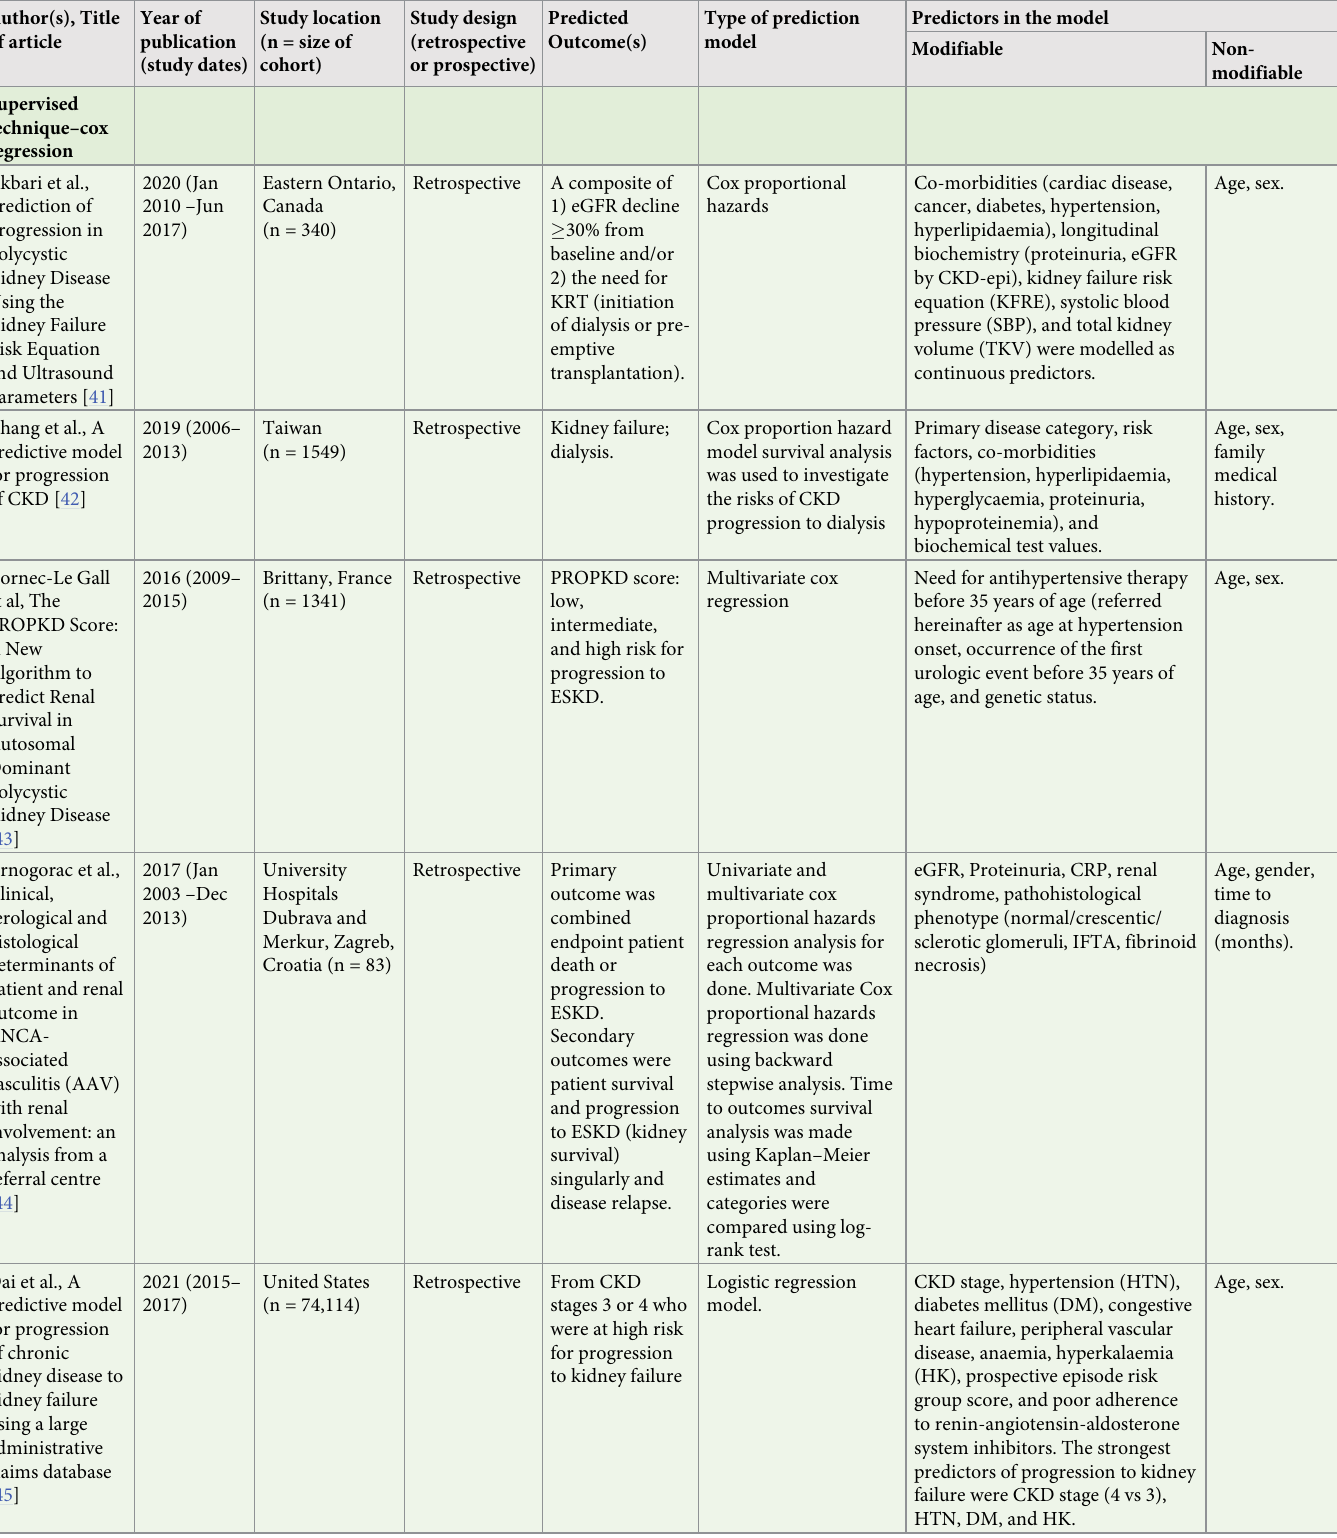
Table 2. Summary of full-text